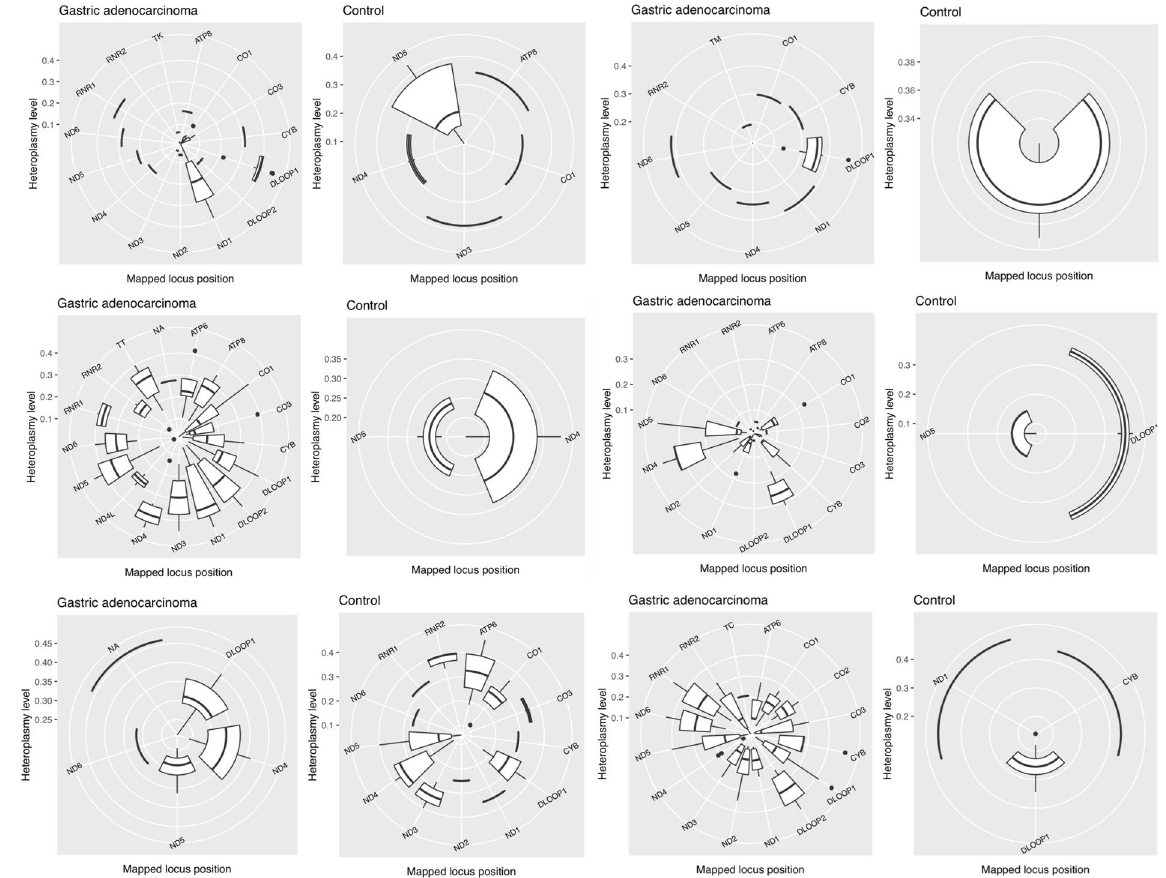
Figure 2. Heteroplasmy levels for each pair of samples from gastric cancer patients, both tumor (gastric adenocarcinoma) and internal control (control). Each boxplot represents the distribution of heteroplasmy in different mitochondrial genes. Non-applicable (NA) represents unidentified